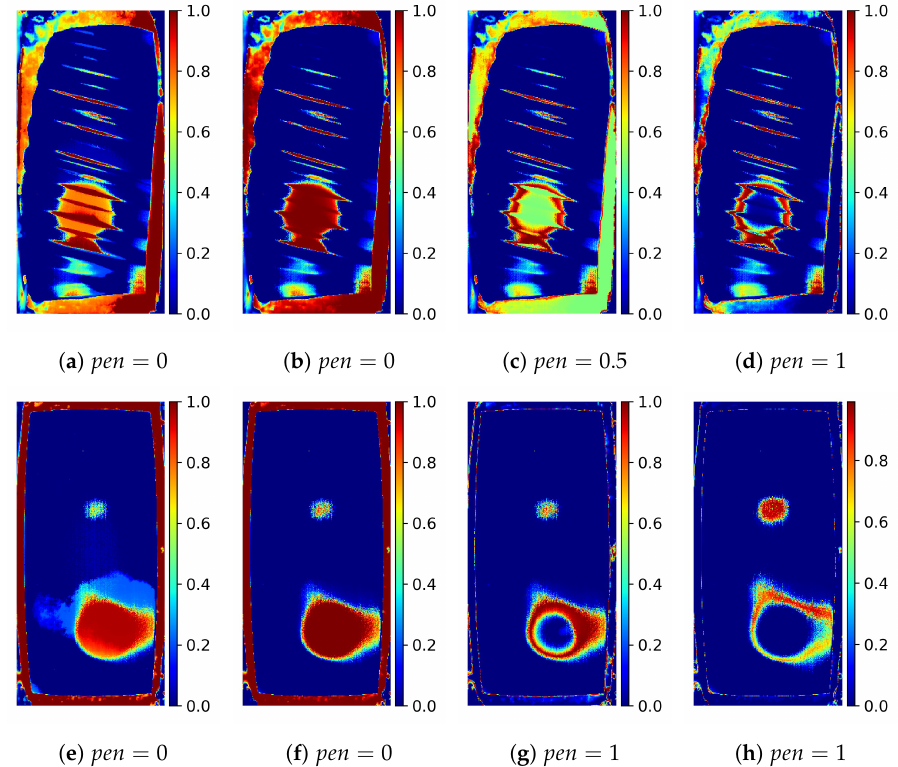
Figure 15. Probability map. ( a – d ) Experiment 3. ( e – h ) Experiment 2. ( a , e ) Computed using all frames. ( b – d , f – h ) Computed using frames of the cooling down phase. All results, except the one shown in ( h ), were obtained with the same c 1 and c 2 ; see the text for the details. pen : the penalty